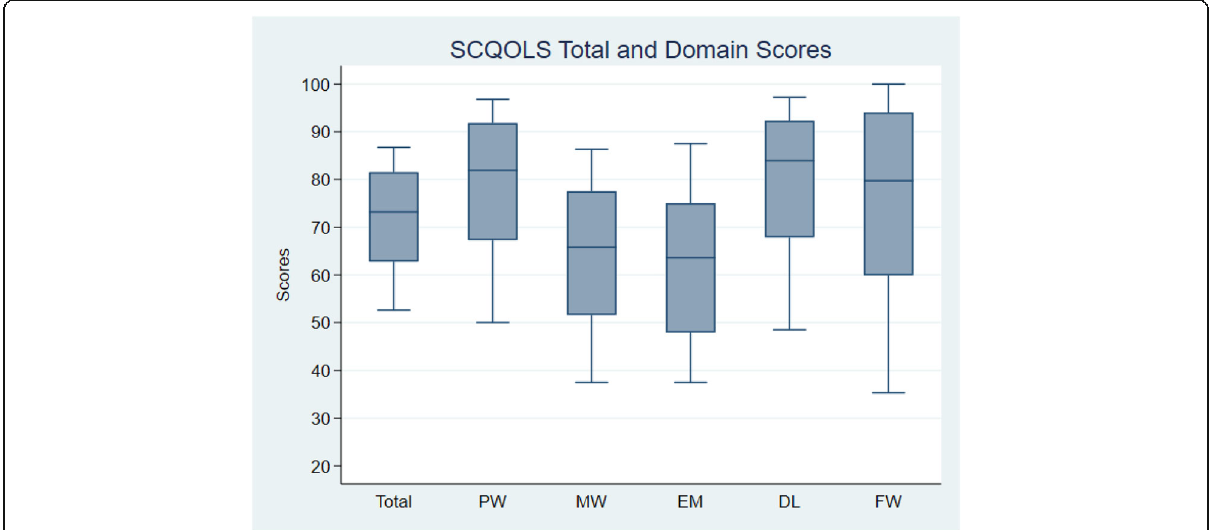
Fig. 1 Plots of 10th, 25th, 50th, 75th and 90th percentiles of quality of life scores of caregivers in a “ mild ” state (patient performance status =1 and caregiver role =1) and, where applicable, in the most common demographic category (ethnic Chinese and tertiary education) and at mean age (48 years) in the survey. Calculation based on equations in Tables 3, 4, 5, 6, 7, 8. PW: Physical Well-being; MW: Mental Well-being; EM: Experience & Meaning; DL: Impact on Daily Life; FW: Financial